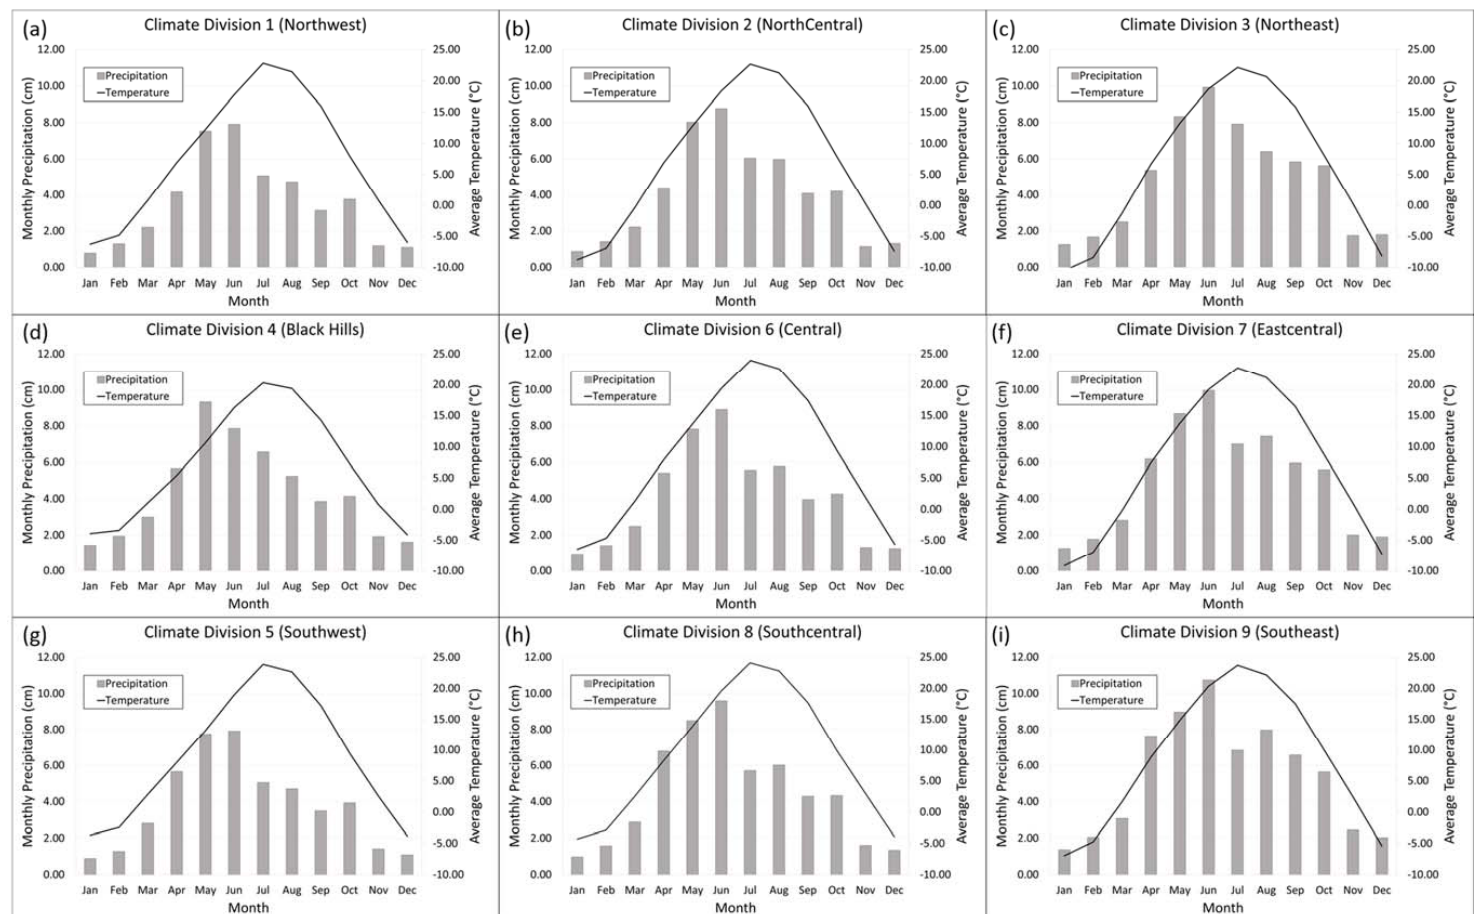
Figure 2. Monthly average precipitation and temperature for South Dakota: ( a ) Climate Division 1 (Northwest); ( b ) Climate Division 2 (Northcentral); ( c ) Climate Division 3 (Northeast); ( d ) Climate Division 4 (Black Hills); ( e ) Climate Division 6 (Central); ( f ) Climate Division 7 (Eastcentral); ( g ) Climate Division 5 (Southwest); ( h ) Climate Division 8 (Southcentral); ( i ) Climate Division 9 (Southeast).